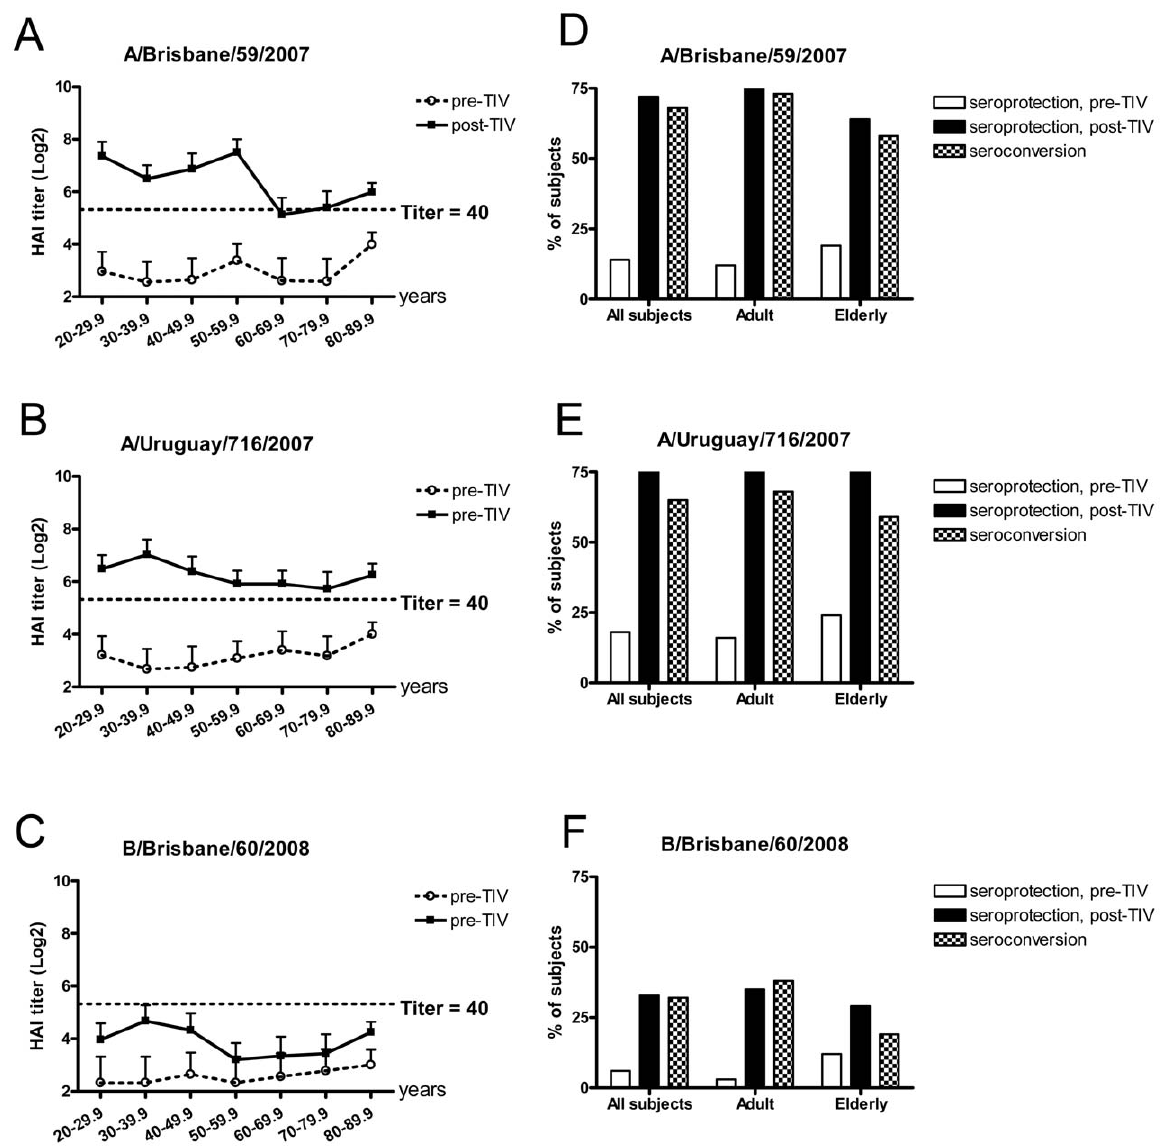
Figure 1. Hemagglutination inhibition (HAI) titers against 2009–2010 seasonal vaccine strains. Serum samples collected from US healthy volunteers vaccinated with 2009–2010 inactivated unadjuvanted trivalent influenza vaccine (TIV) were tested by HAI assay using 0.5% turkey erythrocytes. The geometric mean titers (GMTs), the seroprotection rates (the proportion of subjects having an HAI titer $ 40) before and 21 days after TIV administration, and the seroconversion rates (the proportion of subjects having a $ 4-fold increase in HAI titers) were plotted according to the age distribution of vaccinees for A/Brisbane/59/2007 (H1N1) (A and D), A/Uruguay/716/2007 (H3N2) (B and E), and B/Brisbane/60/2008 (C and F), respectively. The 95% CI for individual HAI GMTs are shown as error bars. The dotted lines indicate HAI titer of 40. (Figure 1C and 1F). Fewer than 35% of the TIV recipients reached a seroprotective titer of 40 or more toward B/Brisbane/ 60/2008. Only 38% of adults and 19% of elderly showed a $ 4- fold rise in B/Brisbane/60/2008 specific HAI titers after TIV vaccination (Figure 1F).